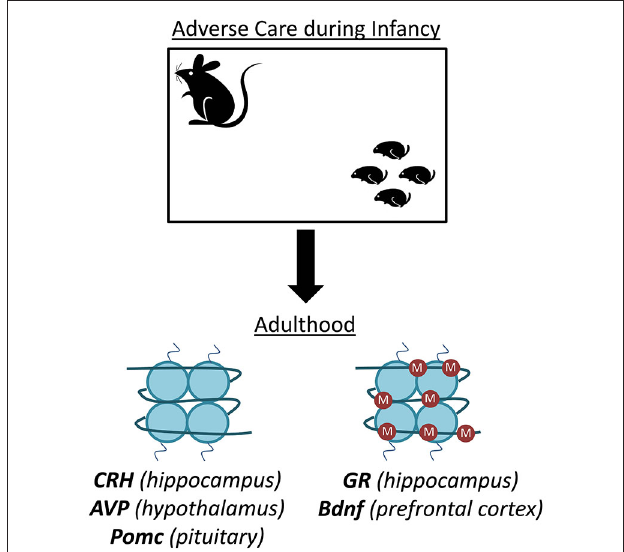
FIGURE 1 | Disruptions in infant care produce DNA methylation alterations in the rodent brain . Both maternal deprivation and aberrant care in rodents lead to altered DNA methylation profiles at numerous gene loci important in stress, emotion, and cognition. For example, offspring that experience this stress display hypomethylation of corticotropin releasing hormone (CRH) in the hippocampus, arginine vasopressin (AVP) in the hypothalamus, and pro-opiomelanocortin (Pomc) in the pituitary. Conversely, the same stress produces hypermethylation of the glucocorticoid receptor (gene) in the hippocampus and brain derived neurotrophic factor (Bdnf) in the prefrontal cortex (PFC).